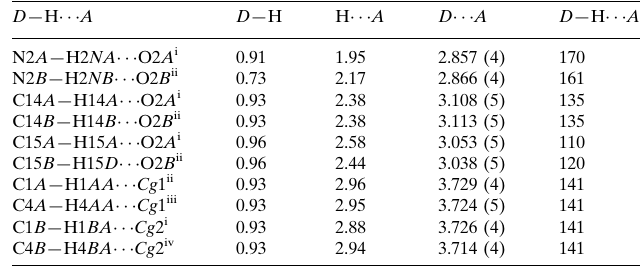
Hydrogen-bond geometry (A˚ , (cid:1)